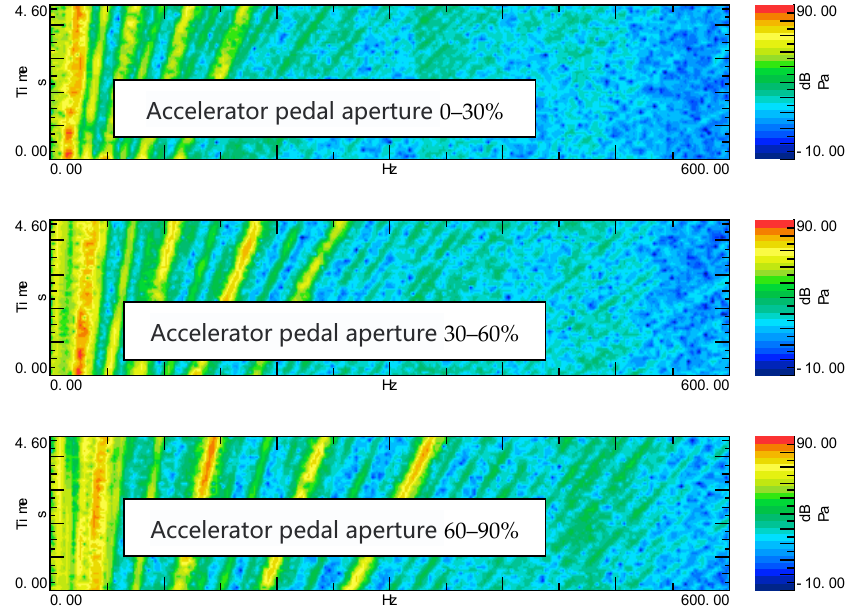
Figure 26. Synthesized sound spectrum under different pedal aperture.